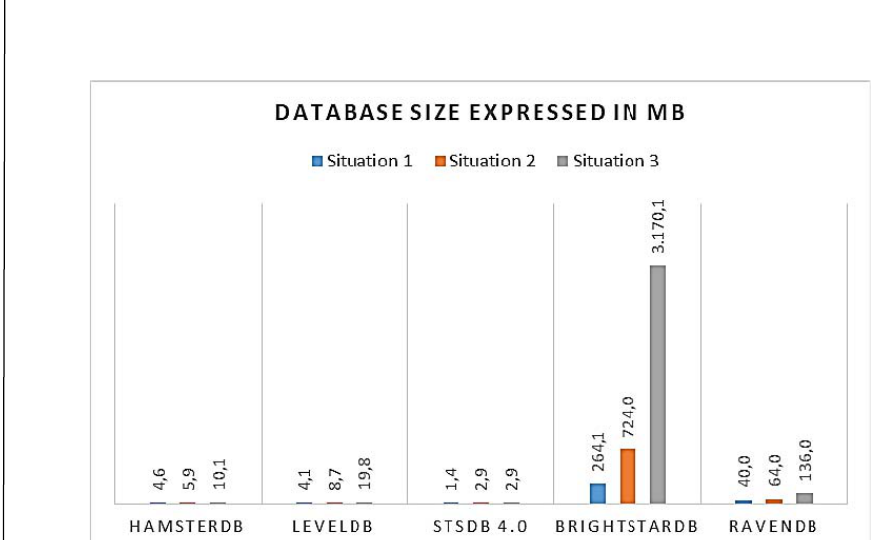
Figure 4 – Database size expressed in MB Рисунок 4 – Размер базы данных , выраженный в MB